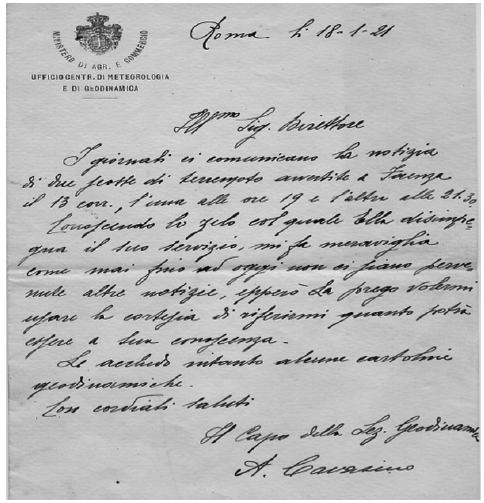
Fig. 5. Letter dated 18th January 1921 in which Al- fonso Cavasino, head of the geodynamic section of the Central Office of Meteorology and Geodynamics asks Bendandi for information about the earthquake recorded in Faenza on 13th January (the first shock was at around 19.00hrs and the other at 21.30hrs).